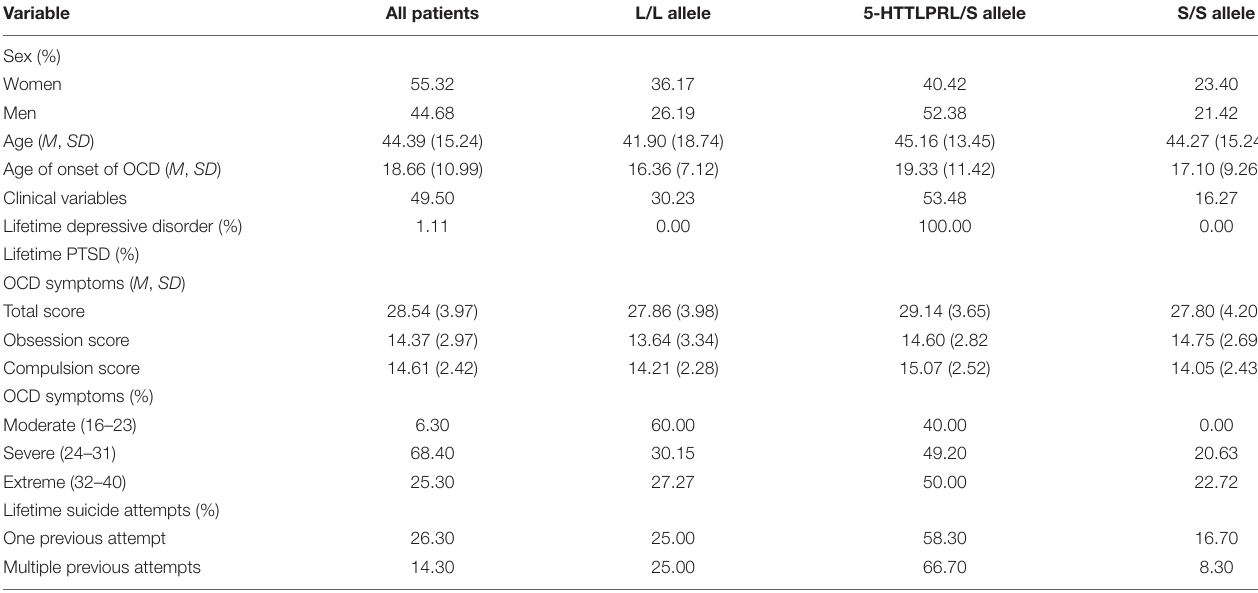
TABLE 1 | Characteristics of the sample.